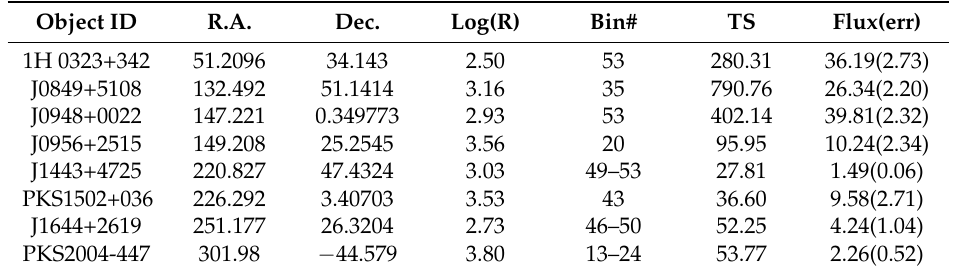
Table 1. Objects in the sample that were detected at gamma-ray energies (Foschini et al. [13], and references therein). (1) Object Name; (2) Right Ascension; (3) Declination; (4) Radio-Loudness; (5) Binning Number; (6) Gamma-ray Test Statistic; (7) Gamma-ray Flux.